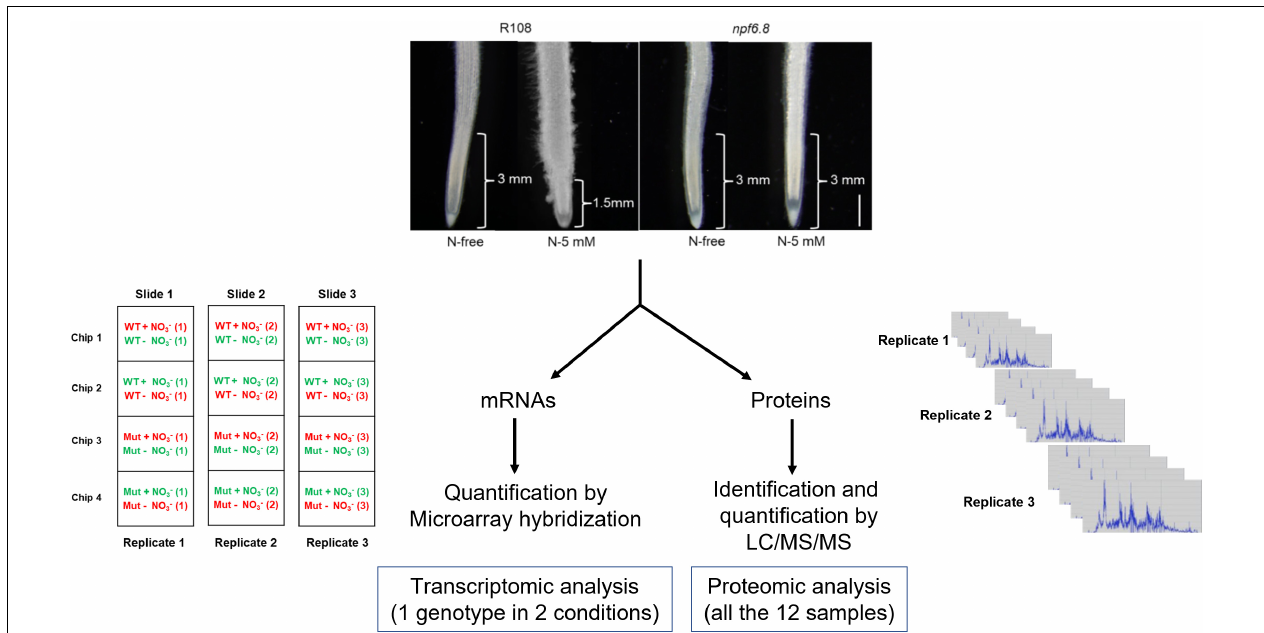
FIGURE 1 | Experimental design for transcriptome and proteome analyses in primary root tip of M. truncatula . The upper part of the figure shows representative photographs of root material used for root tip isolation. The approximate length of root tip collected from R108 and npf6.8-3 seedlings grown in MS without nitrate (N-free) or with 5 mM nitrate (N-5 mM) for 10 days is indicated. Scale bar = 1 mm. For omic studies, three biological replicates were realized, using RNAs and proteins extracted from the same samples. Transcriptomic analysis was performed by co-hybridization on microarrays of cRNAs of R108 (N-free) and R108 (5-mM)